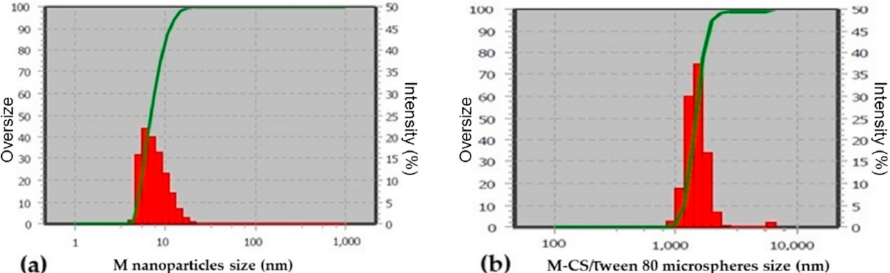
Figure 6. ( a ) Magnetite nanoparticle and ( b ) M-CS/Tween 80 microsphere size distribution. Polydispersity index (PDI) 0.77 and 0.22,